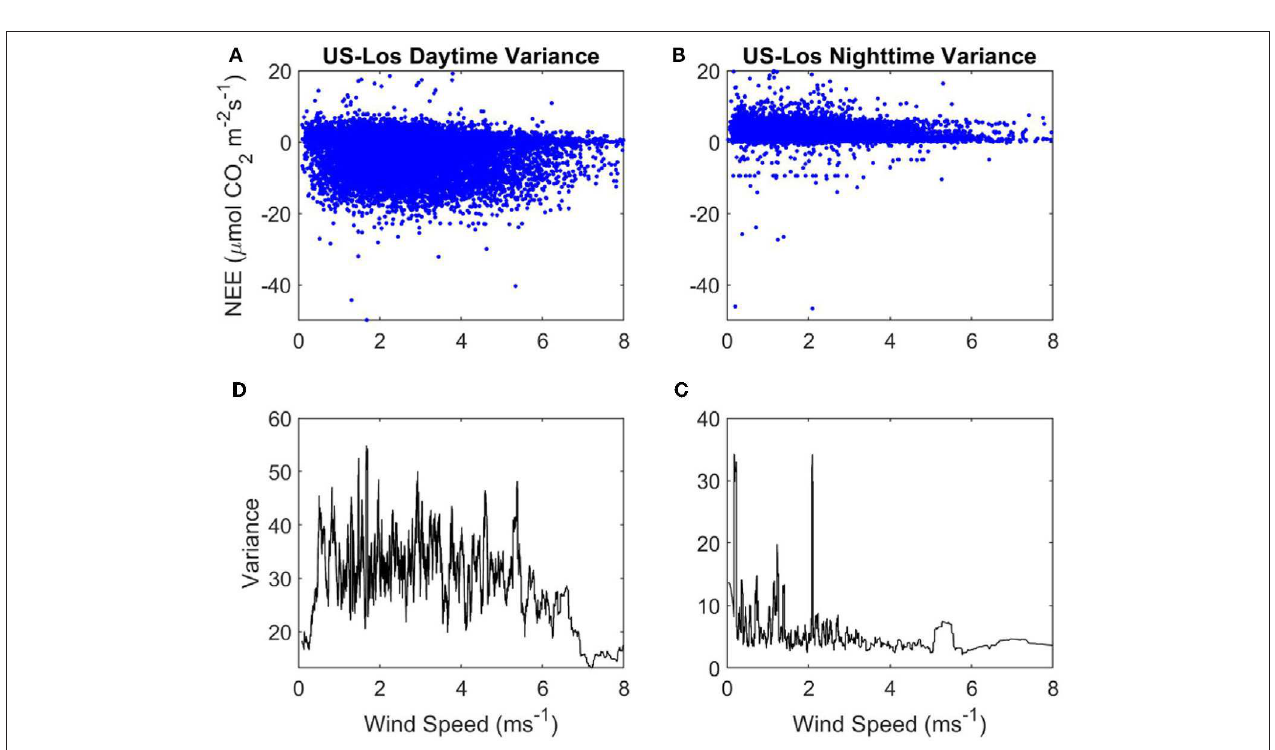
FIGURE 5 | Variance of NEE with WS at the open fen US-Los: (A) Daytime NEE vs. WS. (B) Nighttime NEE vs . WS. (C) Variance of nighttime NEE vs. WS. (D) Variance of daytime NEE vs. WS. Blue, half-hourly NEE; black, variance of NEE.